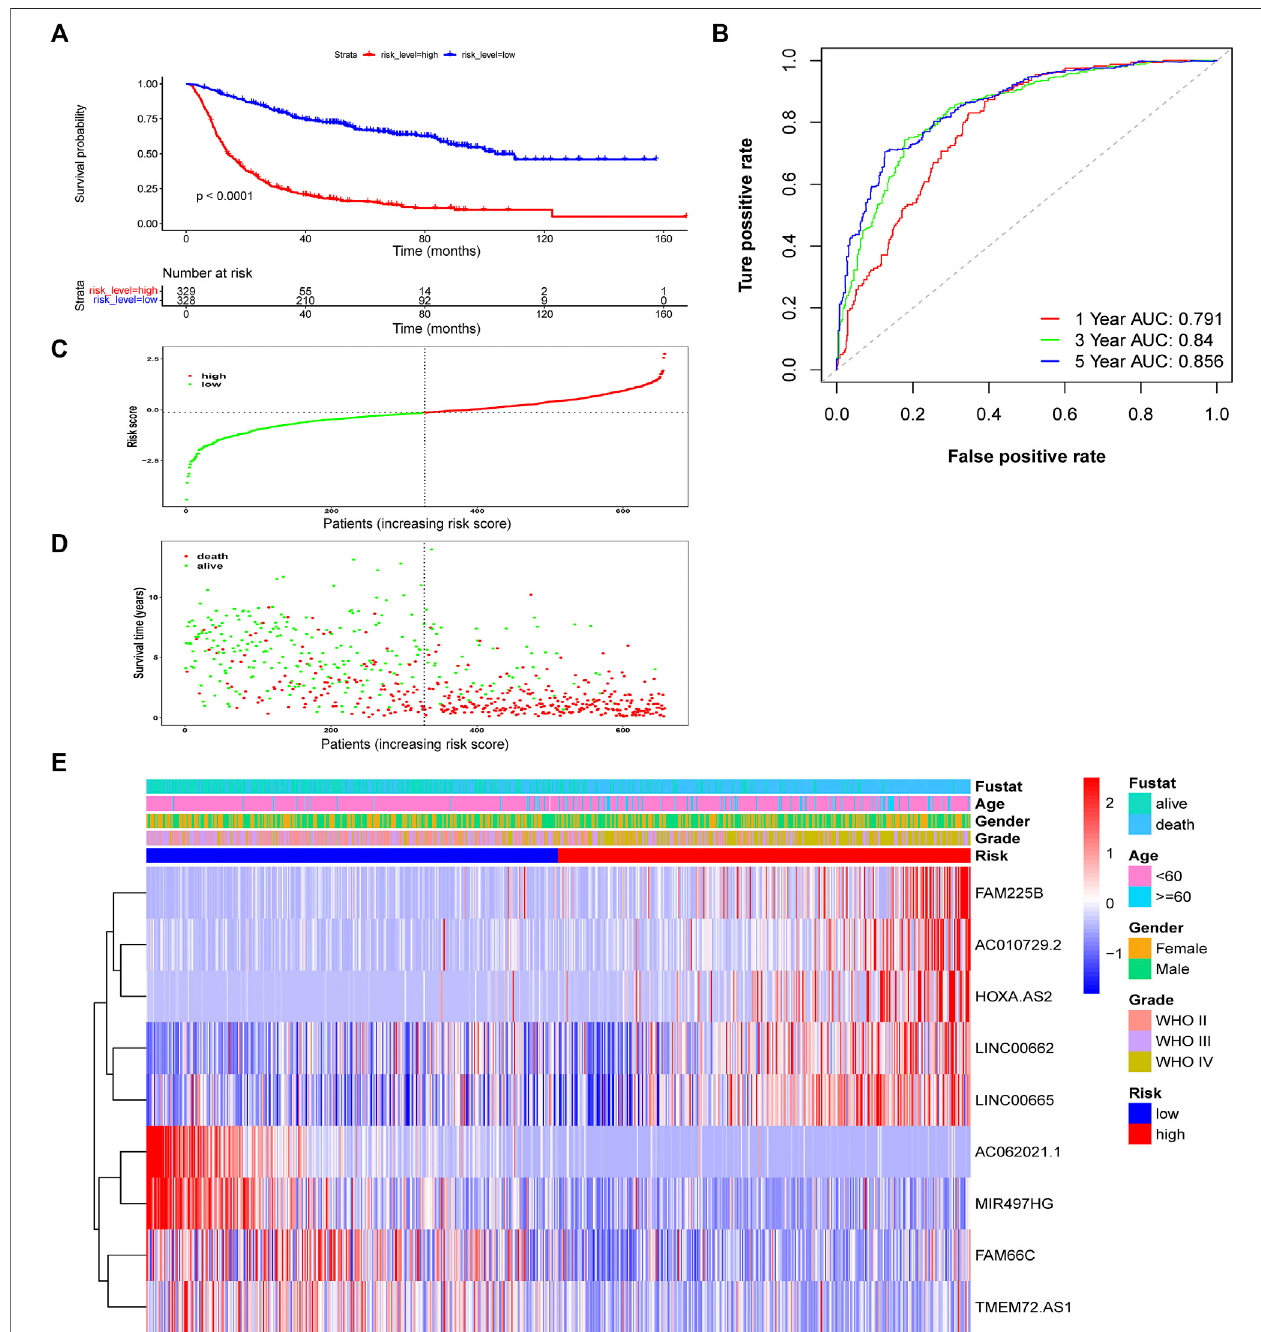
FIGURE 4 | Assessment of the risk score model based on ferroptosis-related prognostic biomarkers in the training CGGA693 cohort. (A) Kaplan-Meier survival based onrisklevel. (B) ROCcurves for predicting OSofglioma patients based onthe riskscore. (C – E) Therisk score,survivaldistributionofpatientswithincreasedrisk scores, and expression heatmap of ferroptosis-related lncRNAs based on risk level.